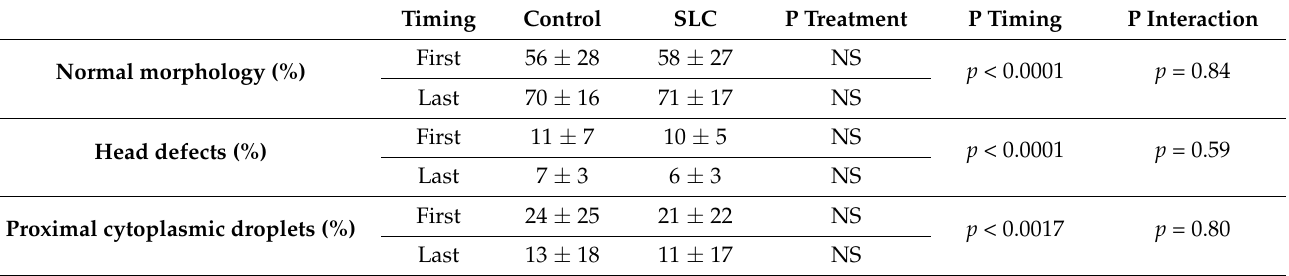
Table 4. Sperm morphology for control and SLC samples from young bull ejaculates (12 bulls).